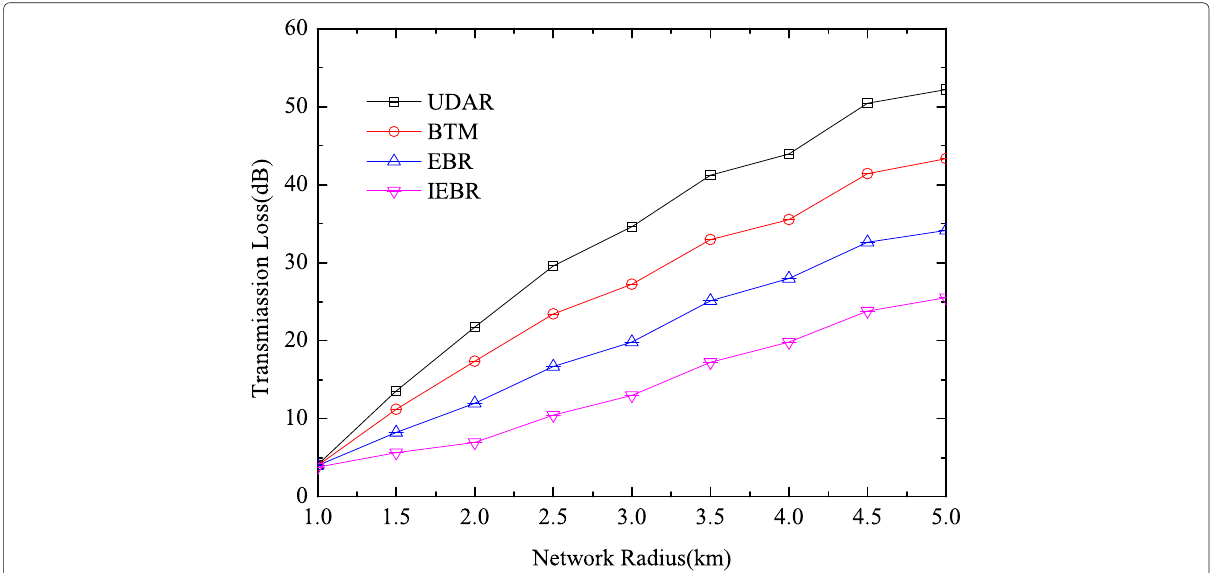
Fig. 9 The transmission loss with different network